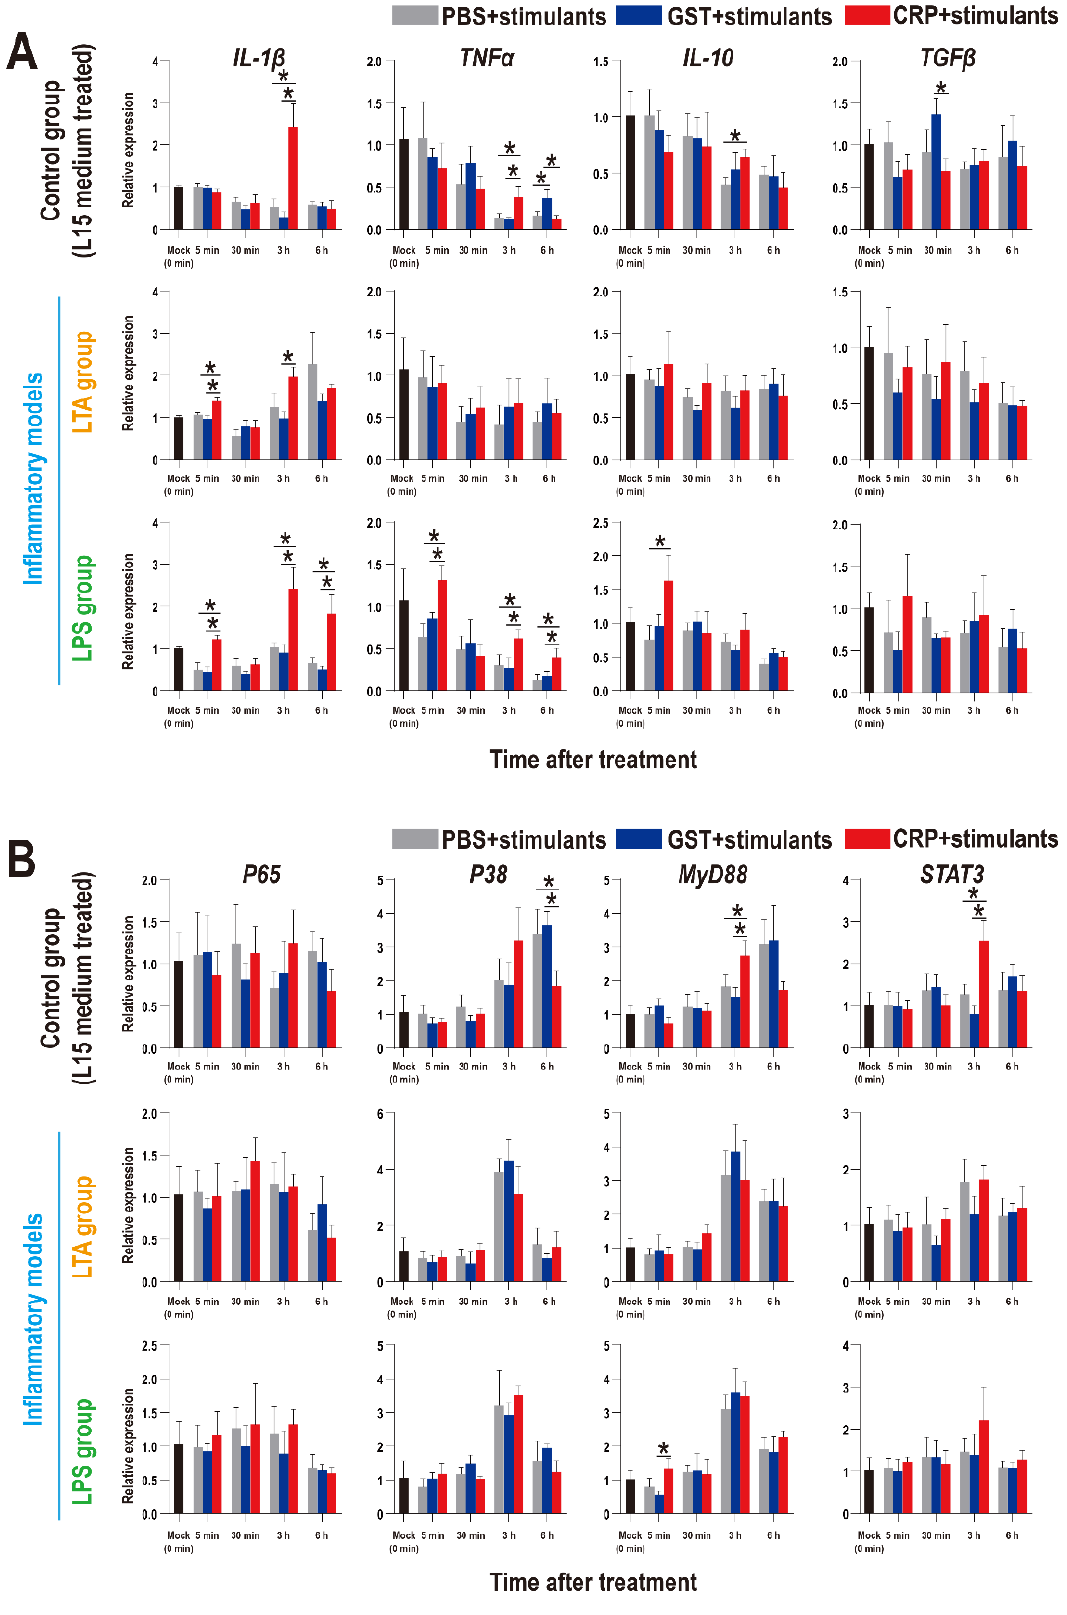
Figure 8. Expression patterns of inflammatory factors ( A ) and key genes of four immune-related pathways ( B ) in HKLs as assessed via qRT-PCR at different time points with different treatments. All values are the mean ± SD; n = 3. Significant difference is indicated by asterisks ( p < 0.05).